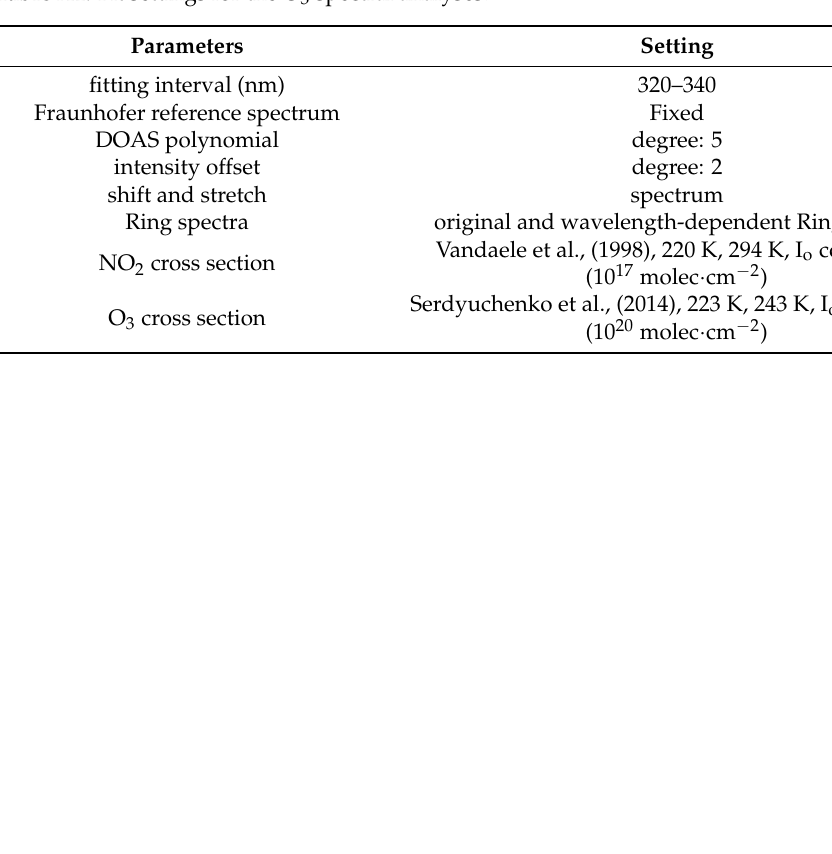
Table A1. Fit settings for the O 3 spectral